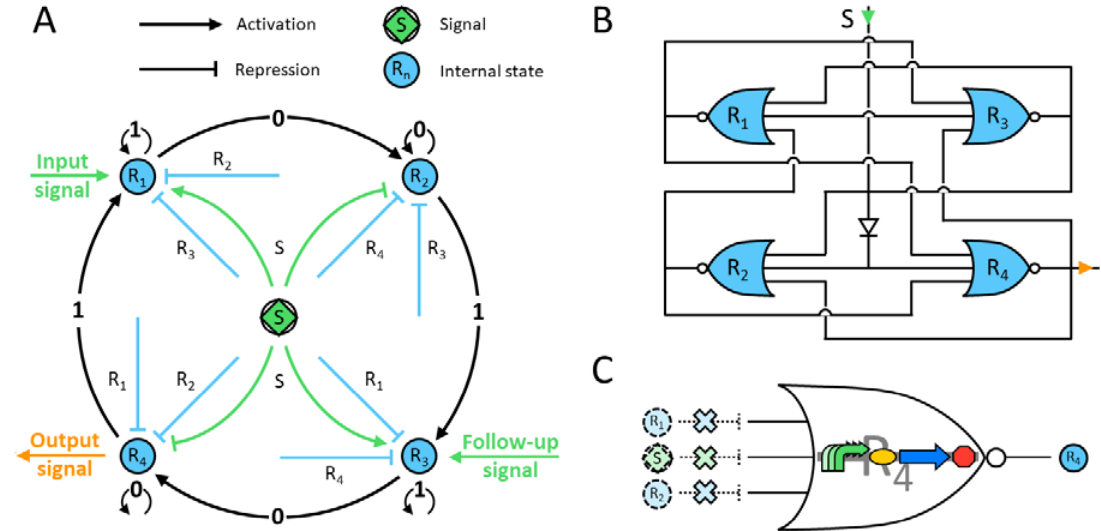
Figure 1. ( A ) Mathematics: scheme of the four-state machine showing the state dependencies and signals. ( B ) Engineering: diagram of the corresponding electronic circuit composed of four 3-input NOR gates. ( C ) Biology: genetic design of a 3-input NOR gate based on a hybrid promoter regulated by three different molecules (e.g., R 4 is produced when R 1 , R 2, and the signal S are absent).